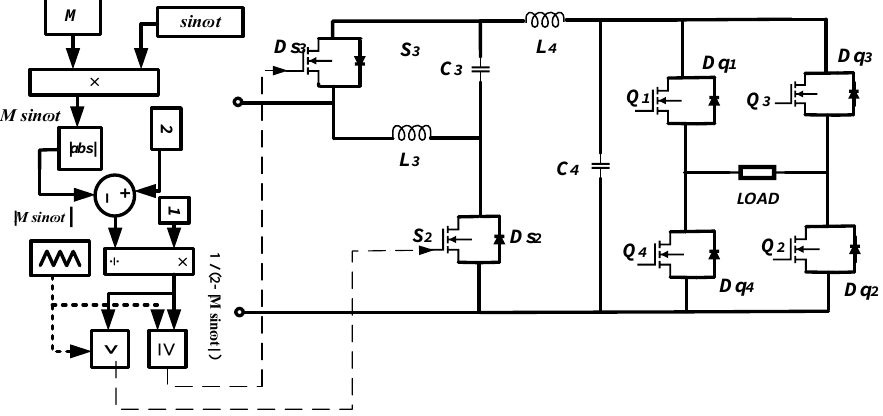
Figure 9. The proposed sinusoidal PWM model for the QZS inverter.